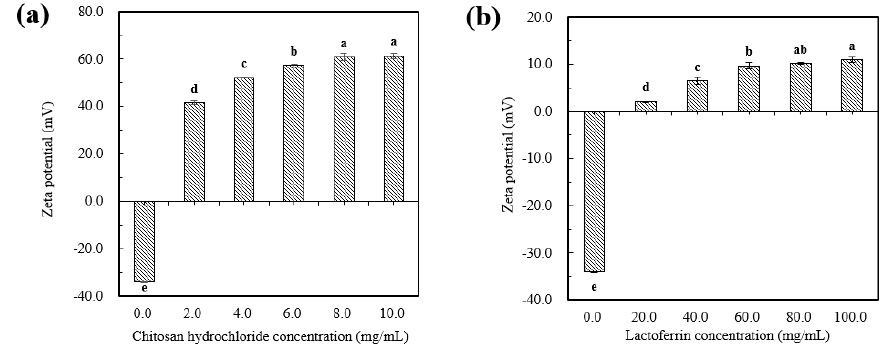
Figure 2. Zeta-potential of liposomes at different concentrations of CH ( a ) and LF ( b ). Different lowercase letters on the column chart indicate significant differences between groups ( p < 0.05).